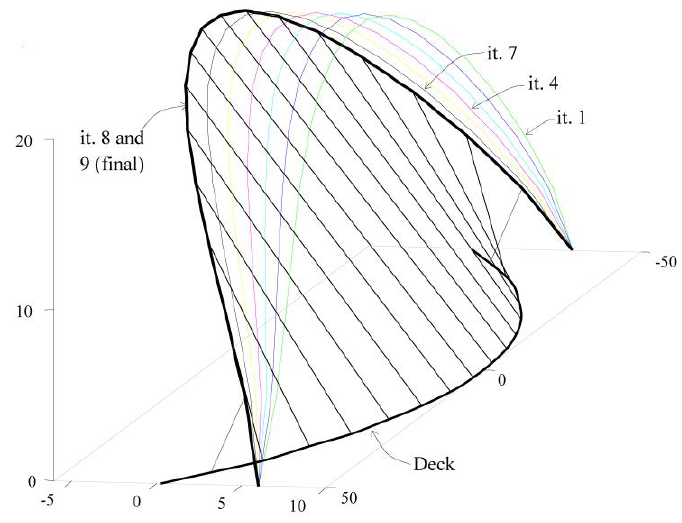
Figure 10. Iterative form-finding (m) by application of the Simplified FDM.